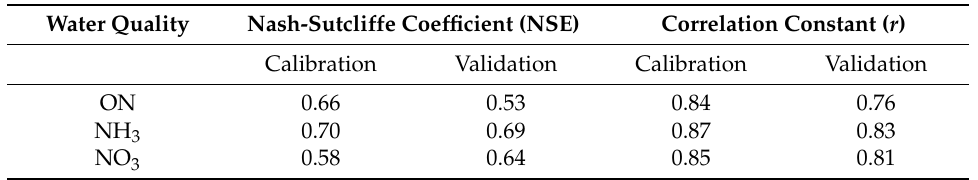
Table 3. Calibration and validation results for simulated concentrations with measured concentrations of ON, NH 3 , and NO 3 .